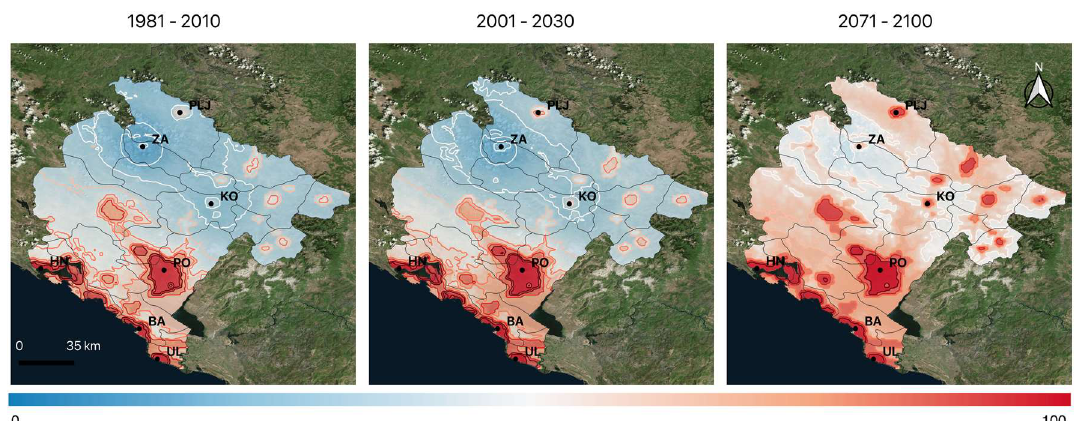
Figure 5. The simulated climatic suitability on a scale of 0–100 for Ae. albopictus for the three integration periods: ( a ) 1981–2010; ( b ) 2001–2030; and ( c ) 2071–2100. The black polygons represent NUTS2-level administrative units of Montenegro.